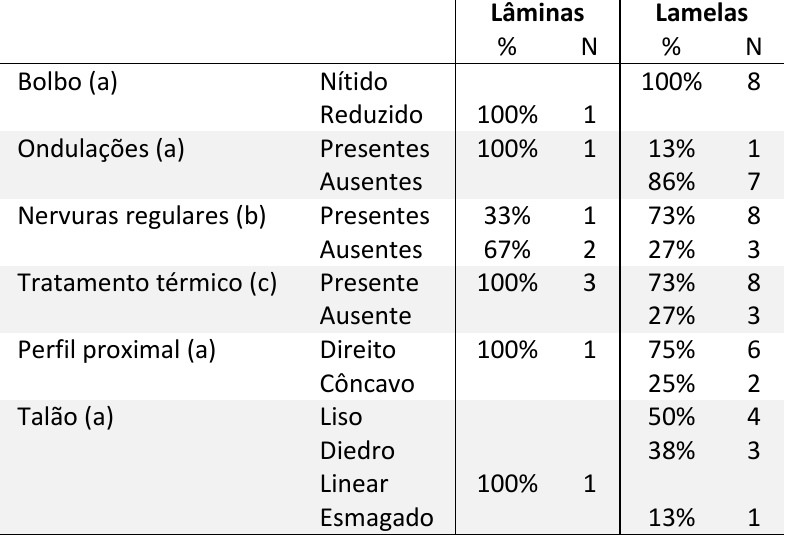
Table 3. Specific attributes of the blade or bladelet knapping in flint from Test 1. (a) Complete and proximal artifacts. (b) complete and broken artifacts. (c) Only flint